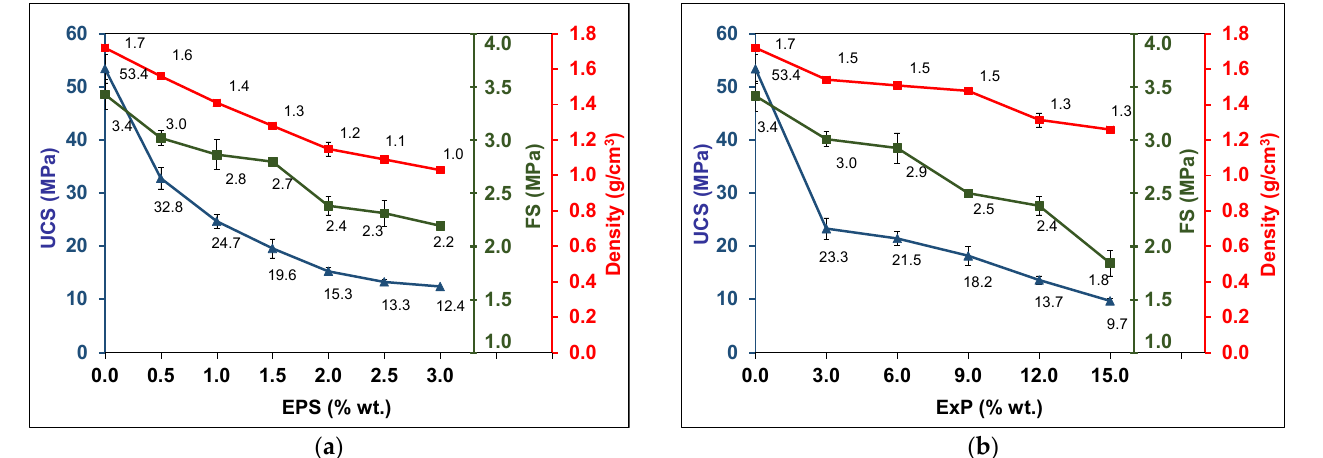
Figure 4. Mechanical properties and density of geopolymers containing EPS ( a ) and ExP ( b ) particles.